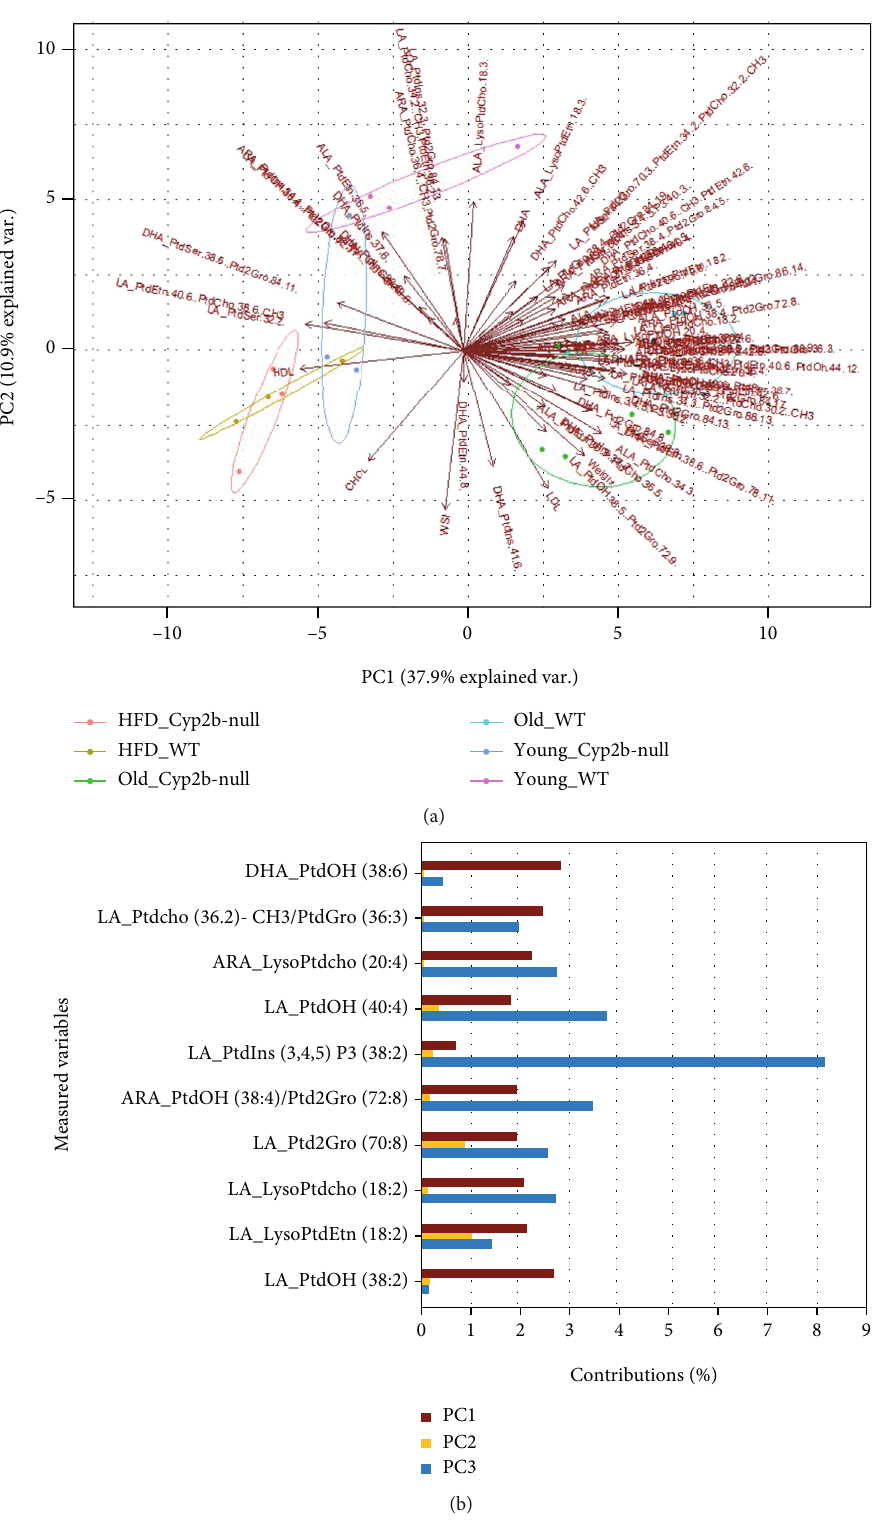
Figure 4: Relationship between treatment groups and measured variables. (a) Principal component analysis (PCA) biplot showing relationships between treatment groups and measured variables such as physiological parameters, serum lipids, and phospholipid species. Variables include serum lipids, WAT somatic index (WSI), body weight, and lipid species in order to associate speci fi c biochemical parameters with di ff erent treatment groups (diet and age) and genotypes (WT and Cyp2b-null). (b) Top 10 contributing variables in the PCA plot based on loading strength expressed in percent